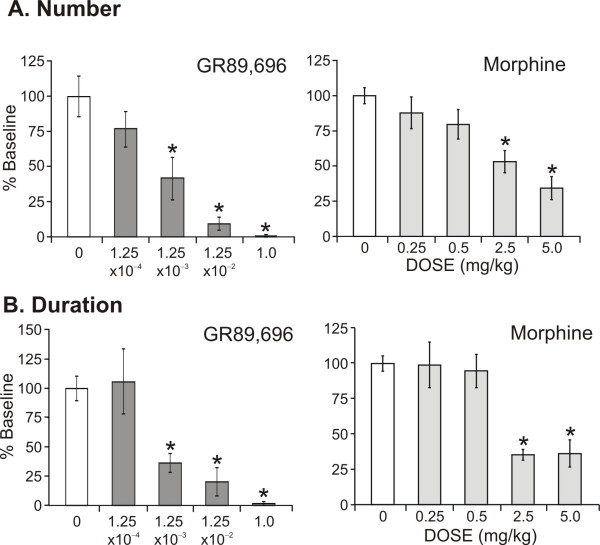
We evaluated the effects of GR89,696 and morphine on reaching activity and cumulative rearing duration. There was a significant dose-related decrease (*P < 0.05) in the number of reaching events (A) and total time spent rearing (B) following morphine (N = 8–12, right insets) or GR89,696 (N = 6, left insets) administration, compared to baseline values.